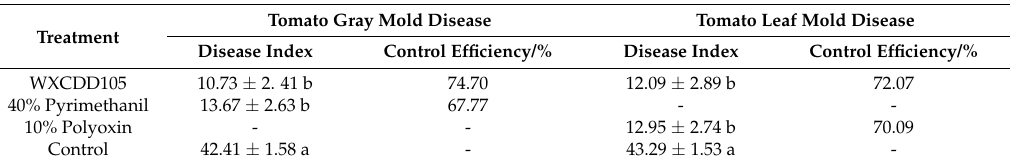
Figure 5. The biocontrol effects of tomato gray mold disease ( A ) and tomato leaf mold disease ( B ) infected tomato leaves. Table 4. The control effects of strain WXCDD105 against tomato gray mold disease and tomato leaf mold disease on seedlings in the pot experiment.